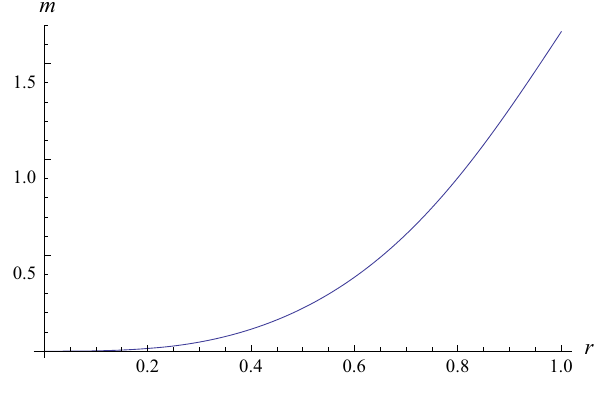
Fig. 3 Mass function for r = 1 and α = 1 . 95 and b = − 10 . 69